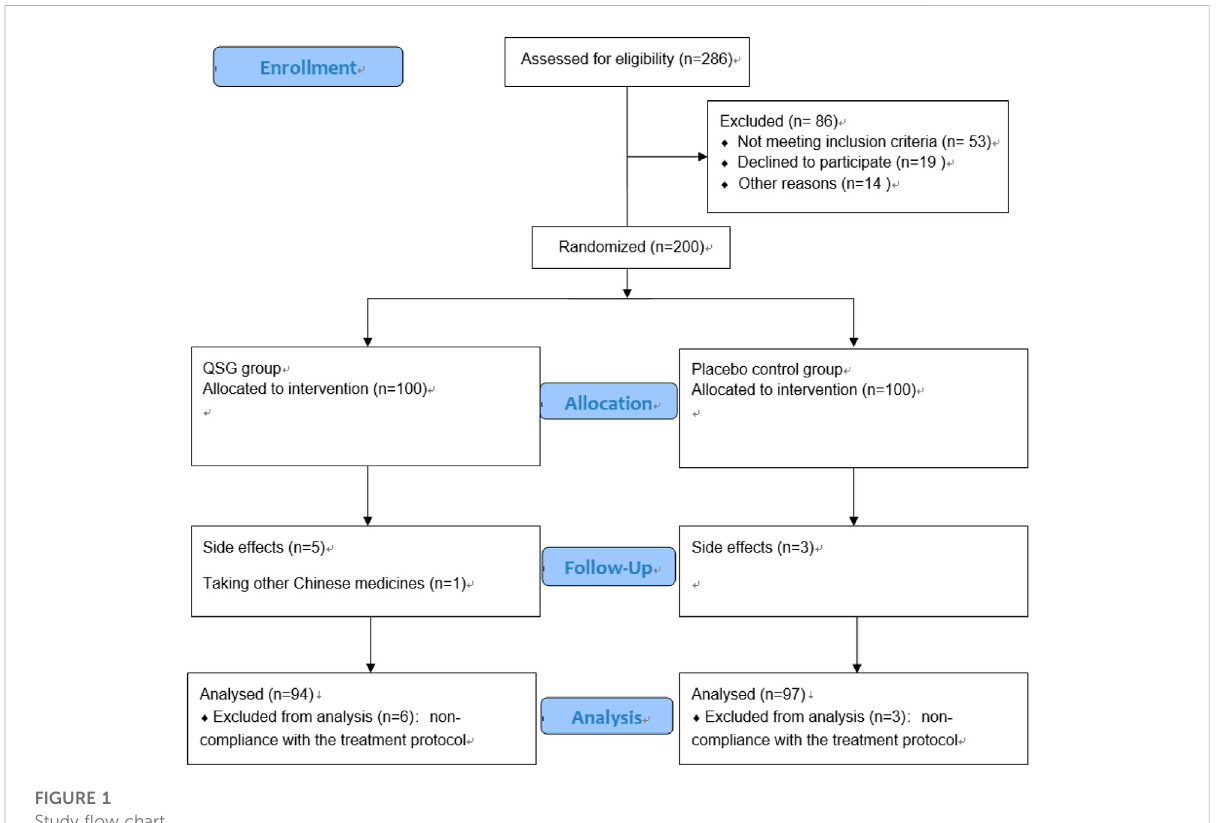
FIGURE 1 Study fl ow